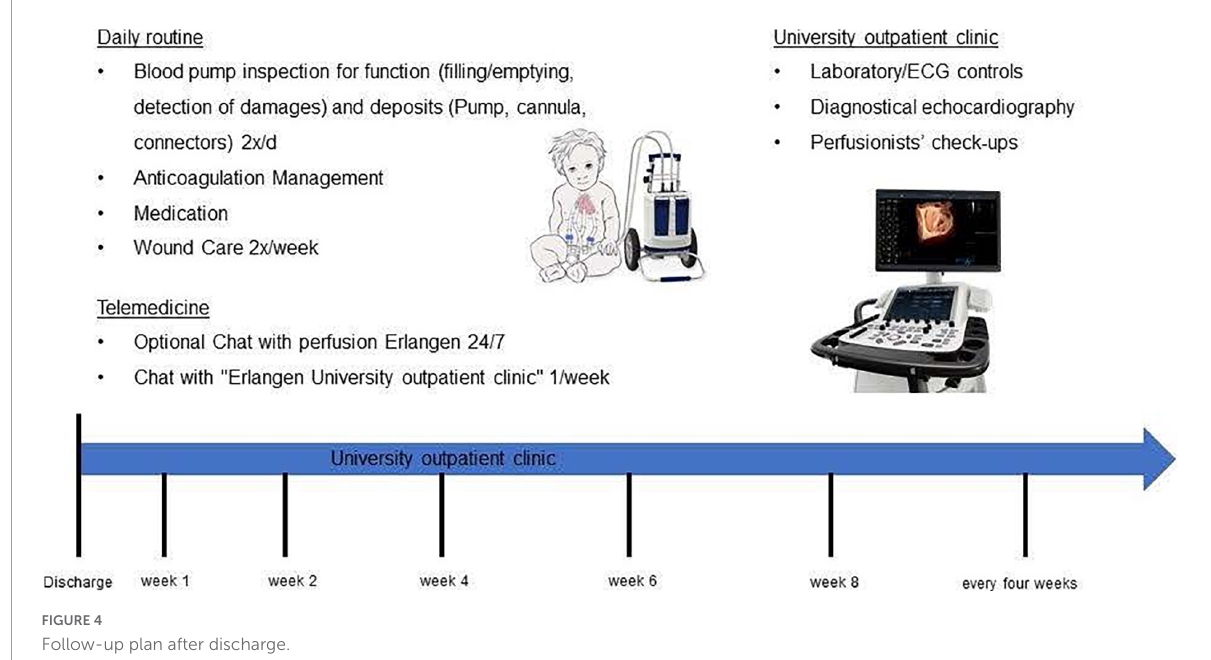
FIGURE4 Follow-up plan after